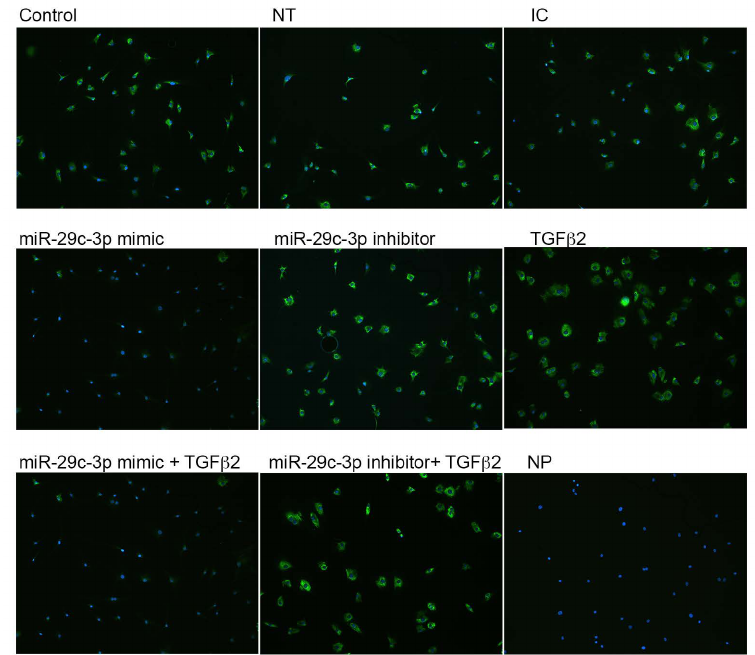
Figure 5. TGF β 2 and miR-29c-3p regulate collagen I expression in LC cells. Primary human LC cells were transfected with miR-29c-3p mimic (10 nM), inhibitor (10 nM), inhibitor control (IC; 10 nM), or non-targeting (NT; 10 nM) control in the presence or absence or TGF β 2 (5 ng/mL) for 72 h. Cells were fixed and immunolabelled with anti-collagen type I antibody (green). Nuclei (blue) were stained with DAPI. NP = no primary Ab control. Representative images are shown. Images taken at 100 × magnification.